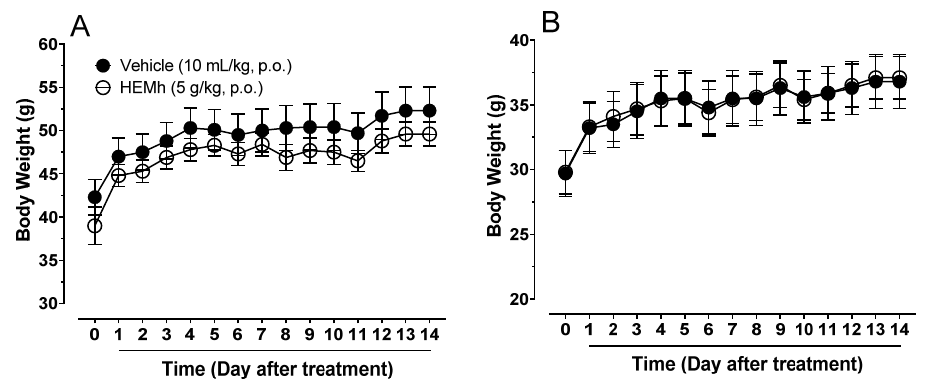
Figure 3. Body weight changes in male ( A ) and female ( B ) mice after acute oral administration (5000 mg/kg) of hydroalcoholic extract of the twigs of Machaerium hirtum (HEMh). The results are expressed as the mean of the values obtained in 10 animals. Student’s t-test. p > 0.05.